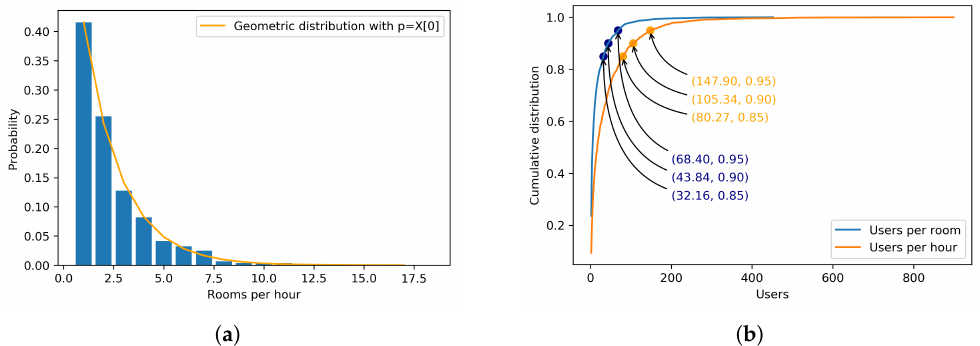
Figure 7. Distribution of users and rooms per hour. ( a ) Number of created rooms per hour; ( b ) Number of users per room or